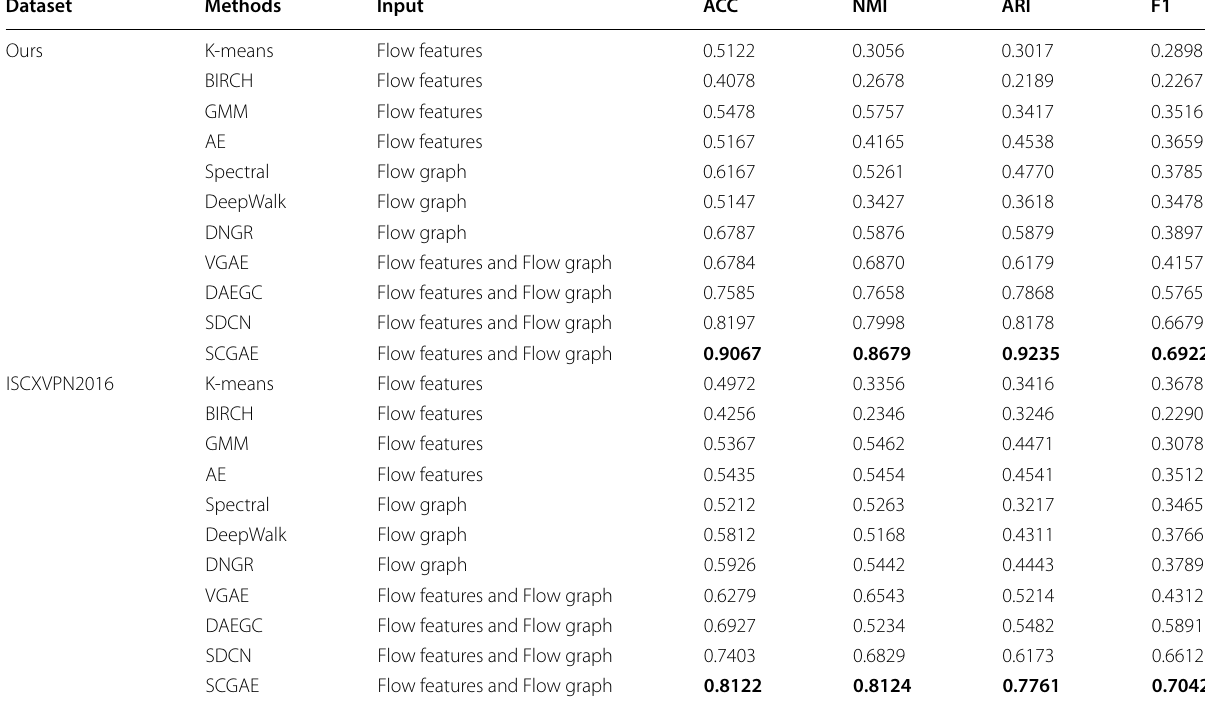
Table 3 Clustering results of various methods